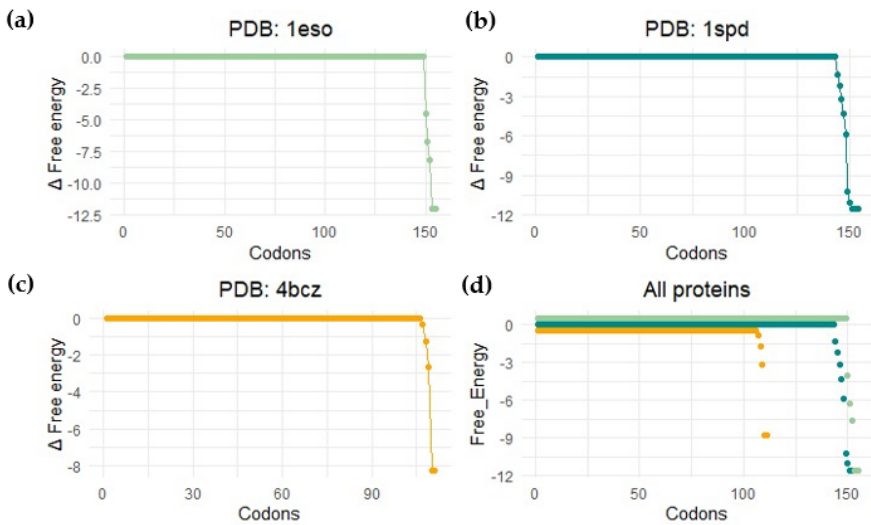
Figure 11. Bioinformatic detection of folding energy release. This image shows the free energy calculation results by performing a coarse-grained calculation of cotranslational folding (software published in [102]). Profile for ( a ) Escherichia coli SodC (Superoxide dismutase Cu-Zn, PDB: 1eso); ( b ) human-related amyotrophic lateral sclerosis CuZn superoxide dismutase (PDB: 1spd); ( c ) monomeric human CuZn superoxide dismutase in which loops IV and VII are deleted (PDB: 4bcz); ( d ) all proteins.